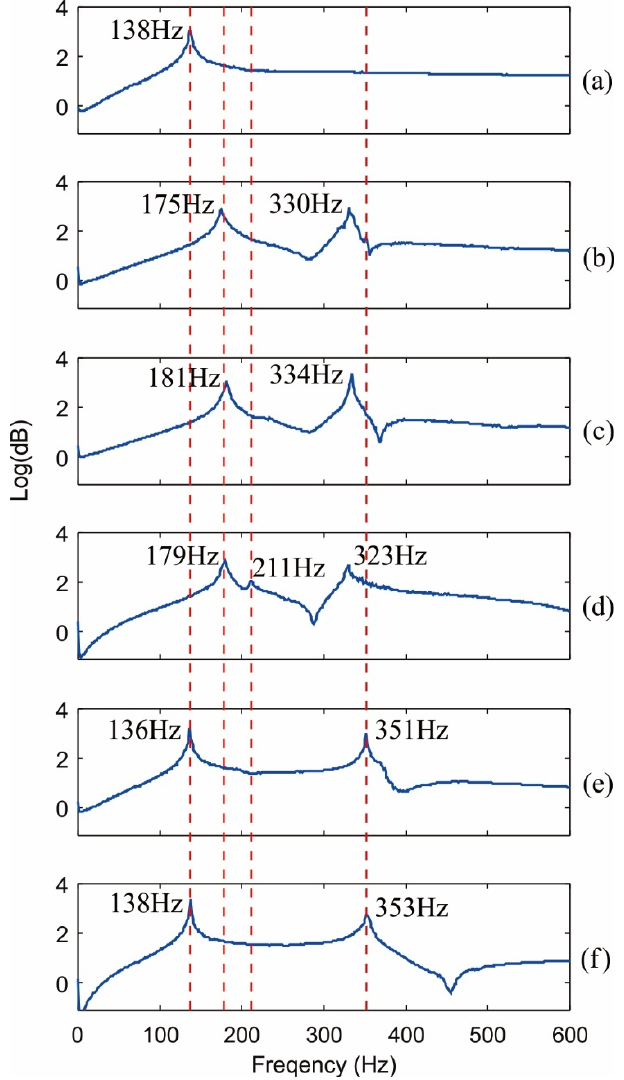
Figure 11. Experimental dynamic response of the CPM: ( a – c ) along the Z, X, and Y axes, respectively; ( d – f ) about the Z, X, and Y axes, respectively.